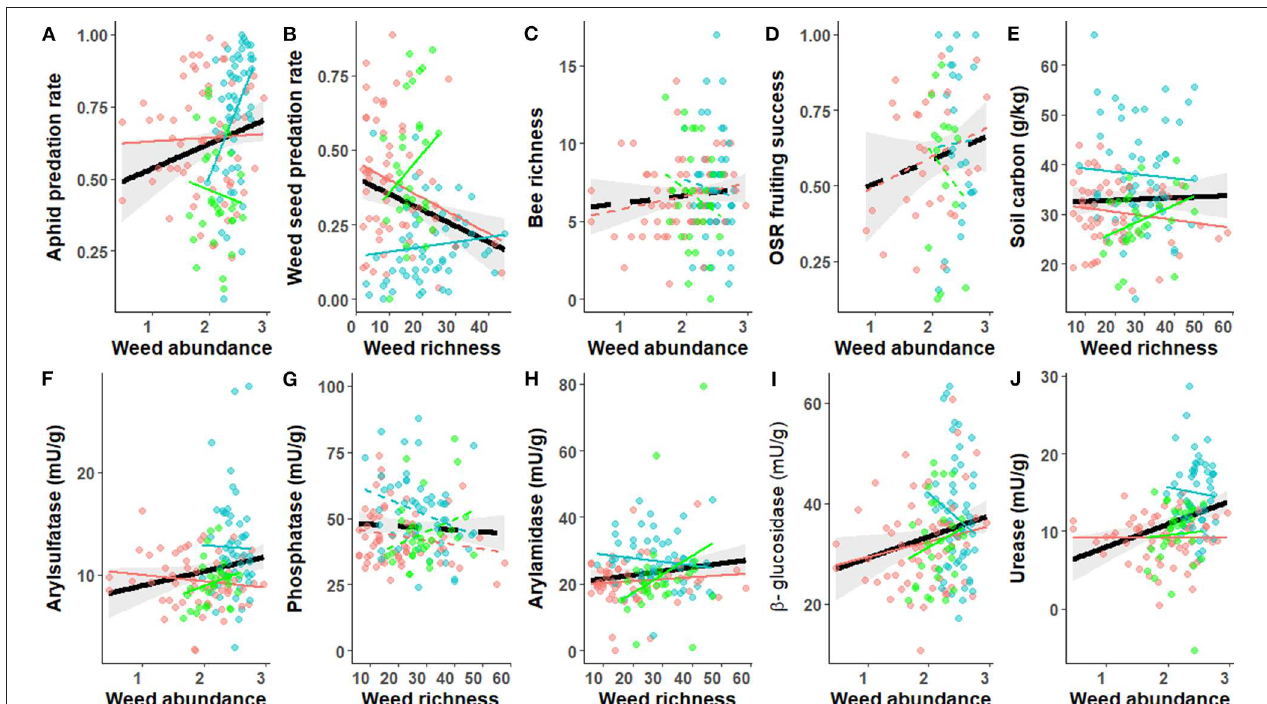
FIGURE 4 | Weed abundance or richness effect on each ecological function in winter cereals (red), oilseed rape (green) and haylands (blue). Ecological functions are: aphid predation rate (A) , weed seed predation rate (B) , bee richness (C) , OSR fruiting success (D) , soil carbon (E) , arylsulfatase (F) , phosphatase (G) , arylamidase (H) , β -glucosidase (I) and urease (J) . Lines represent the predicted relationship from the statistical models. The black line shows the relationship across crop types and shade area the 95% confidence interval. Dotted lines indicate non-significant relationships. Weed abundance is log-transformed. Soil enzyme activities are expressed in mU.g − 1 dry soil, representing nanomoles of product released per minute and per g of equivalent dry soil.